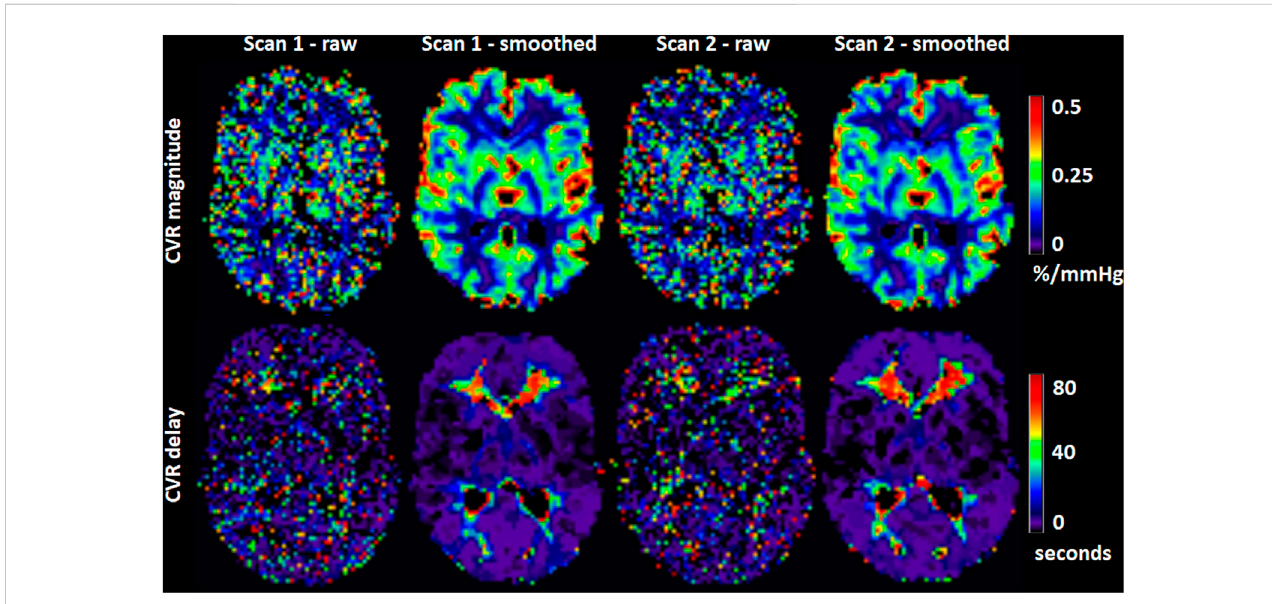
FIGURE 4 Maps of CVR magnitude and delay from one representative participant obtained from scan 1 and 2. The smoothed maps were obtained after spatially smoothing the BOLD volumes using a Gaussian fi lter with full width at half maximum of 4 mm and are shown here for visual purposes